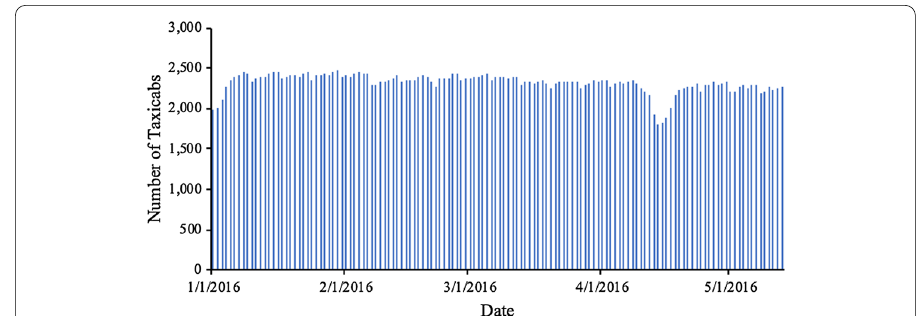
Fig. 3 Number of active taxicabs from January through May of 2016